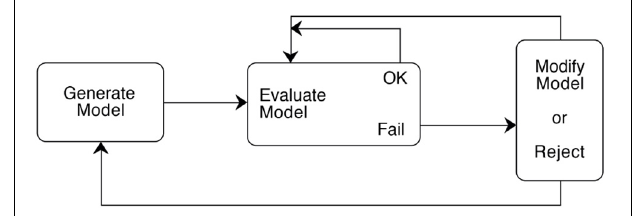
FIGURE 1 | Model construction cycle of Model Generation, Evaluation, and Modification (GEM cycle). (1) A hypothesized model is generated. (2) The model is evaluated with respect to whether it plausibly explains target observations and whether there are any problems with the model in meeting certain scientific criteria, or conflicting with observations, constraints, or other theories. If it passes, other criteria may be found for further evaluation. If it doesn’t pass and the failure is fatal, the model is rejected, and one returns anew to the Generation process. Otherwise, a new constraint on the model can be noted and attempts can be made to modify the model within existing constraints. More than one modification may be made. (3) The modified model is evaluated, and the cycle of modifications and evaluations can continue until either the investigator gives up, or the model withstands evaluation sufficiently enough to satisfy the modeler for their purposes. (Reproduced with permission from Clement, 2008, p.